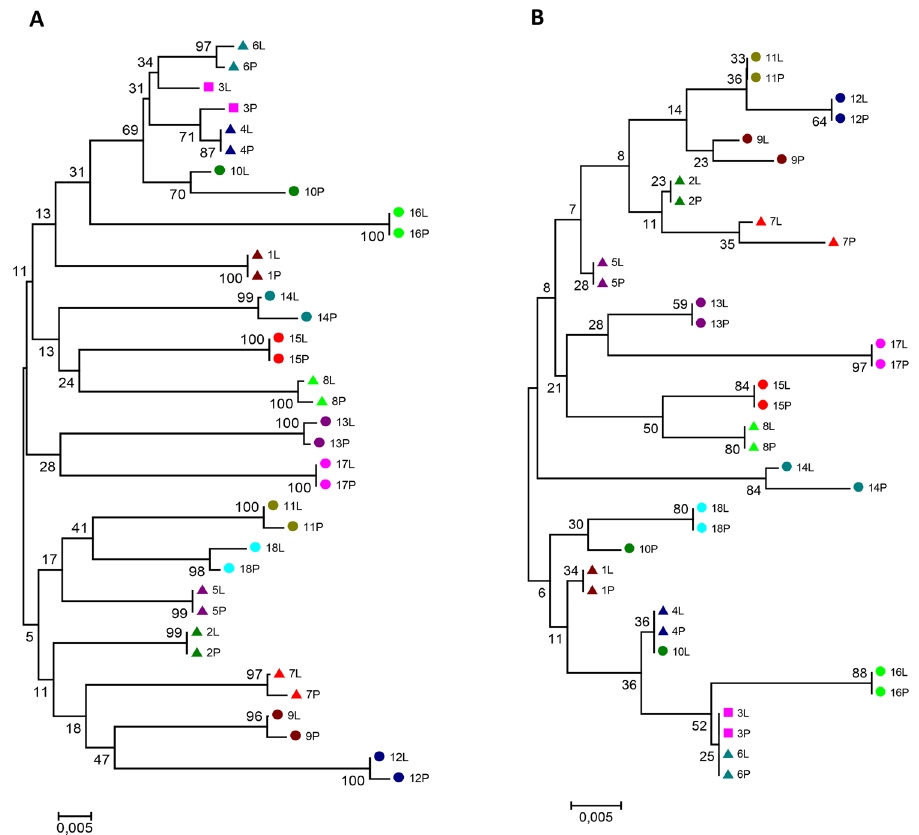
Figure 2. Phylogenetic analysis of the partial NS5B consensus nucleotide ( A ) and deduced amino acid ( B ) sequences from plasma and corresponding liver biopsies from HCV patients. Phylogenetic trees were generated using MEGA5, with the neighbour-joining method with p-distance model and 1,000 bootstrap replicates. Bootstrap values are shown. The different patients are indicated by colour, shape, and numbering with liver (L) and plasma (P) sequences